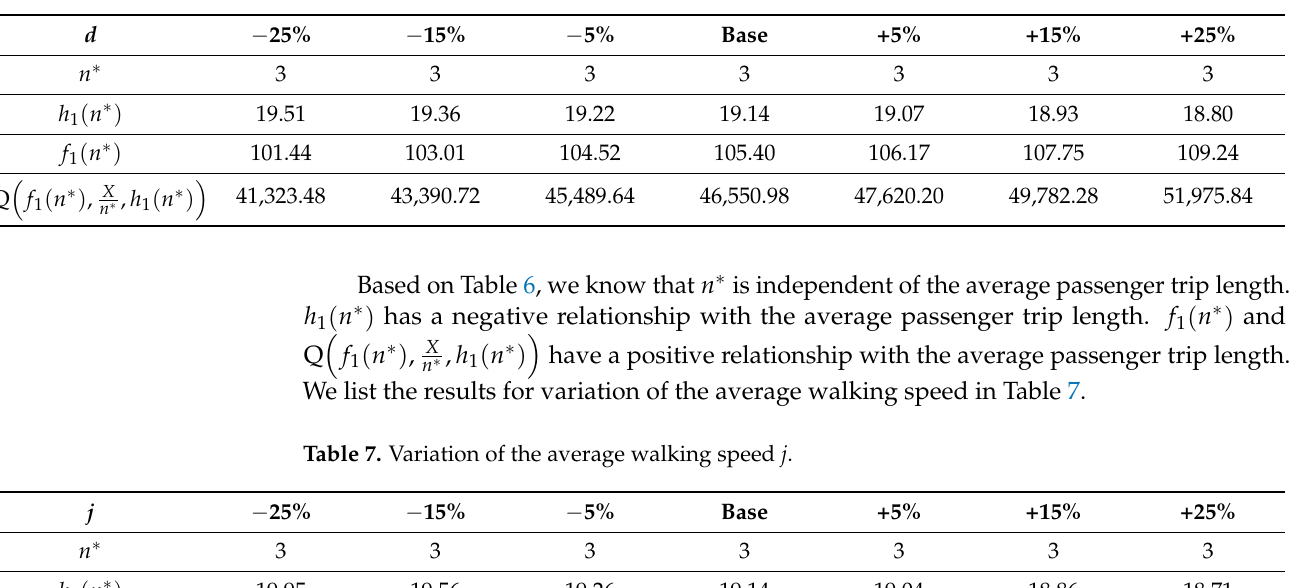
Table 6. Variation of the average passenger trip length d .